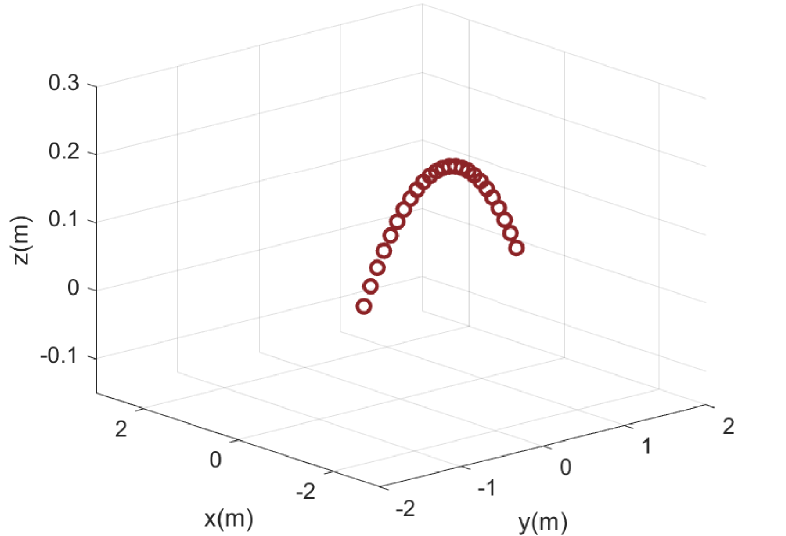
Fig 1. The trajectory of table tennis. The picture shows the trajectory of a table